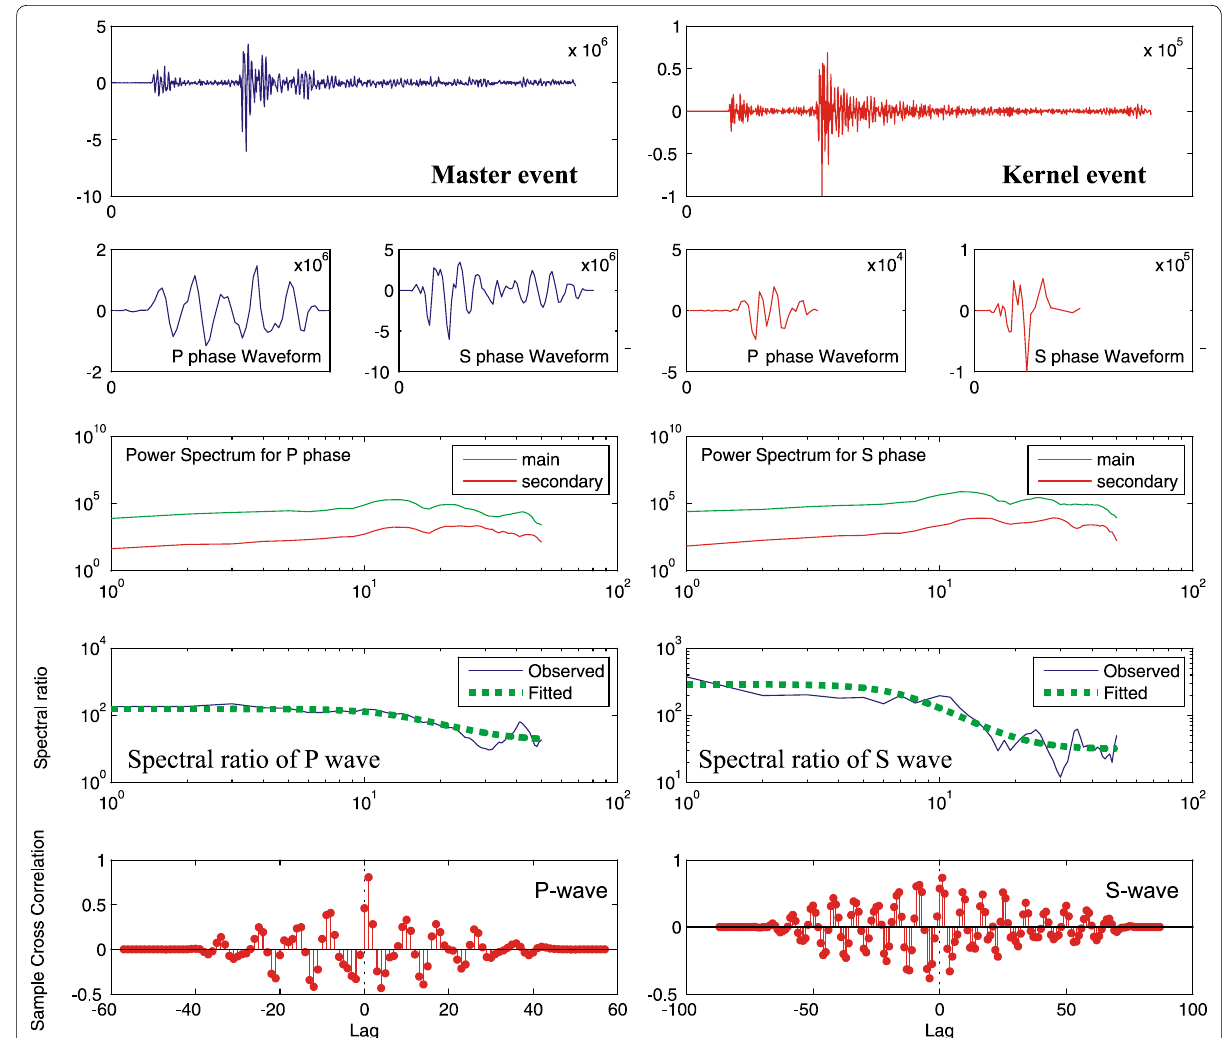
Fig. 8 An example of the analysis of spectral ratios for P‑ and S‑waves to estimate the seismic moment ratio and the corner frequencies of the master event (2017/11/03 01:06:52.746 UTC) to its kernel event (2017/11/03 07:53:11.632 UTC) recorded by the NAMS